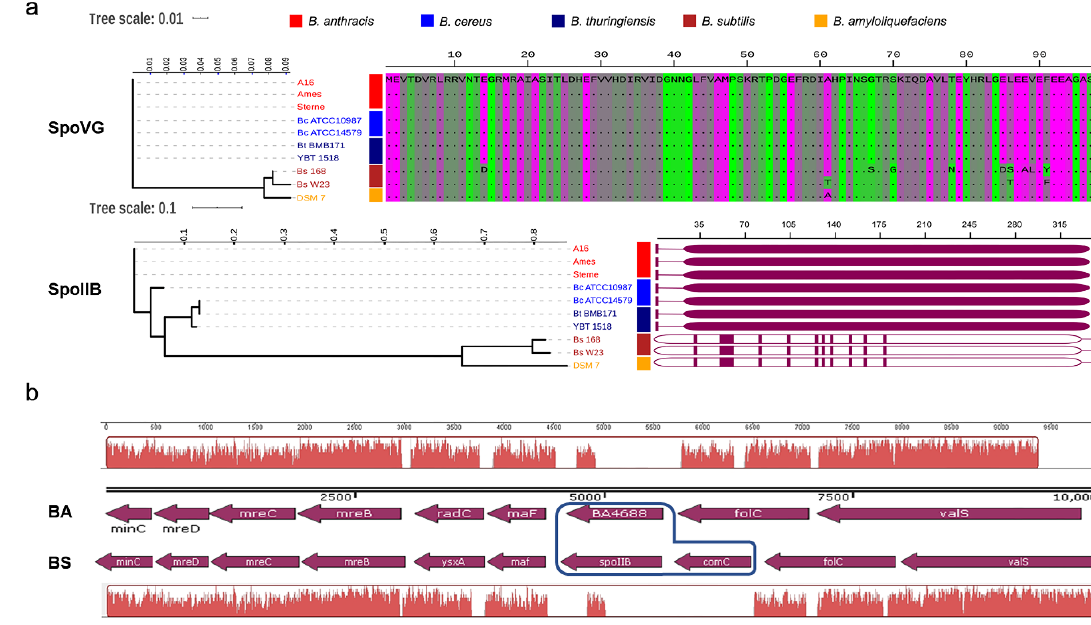
Figure 4. Amino acid sequence similarity of SpoVG and SpoIIB from species in the B. cereus group compared with those in B. subtilis . ( a ) Phylogenetic trees based on amino acid sequence alignment of SpoVG and SpoIIB, respectively. The unweighted pair group method with mean averages (UPGMA) tree was based on alignment of 10 amino acid sequences of SpoVG and SpoIIB proteins from strains belonging to the B. cereus group (seven sequences, including sequences from B. anthracis ), B. subtilis (two sequences), and B. amyloliquefaciens (one sequence) available in the NCBI database (https://www.ncbi.nlm.nih.gov/). Multiple sequence alignment was conducted using ClustalX, and the tree was generated using Mega X software. The schematic shows regions of similarity rather than the complete sequence because of the length of the SpoIIB protein. SpoVG is highly conserved between B. anthracis and B. subtilis , while BA4688 (from B. anthracis ) and SpoIIB Bs (from B. subtilis ) share a low amino acid sequence similarity. ( b ) Comparison of the spoIIB locus across Bacillus species. Arrows indicate the